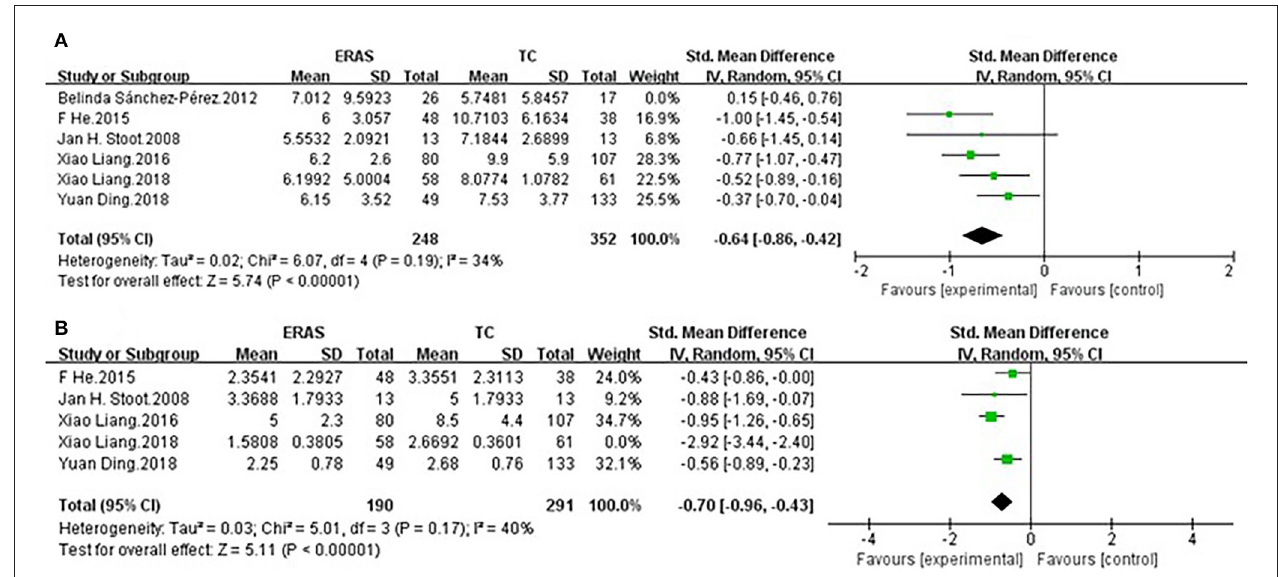
FIGURE 4 | Sensitivity analysis of (A) LOS and (B) duration to functional